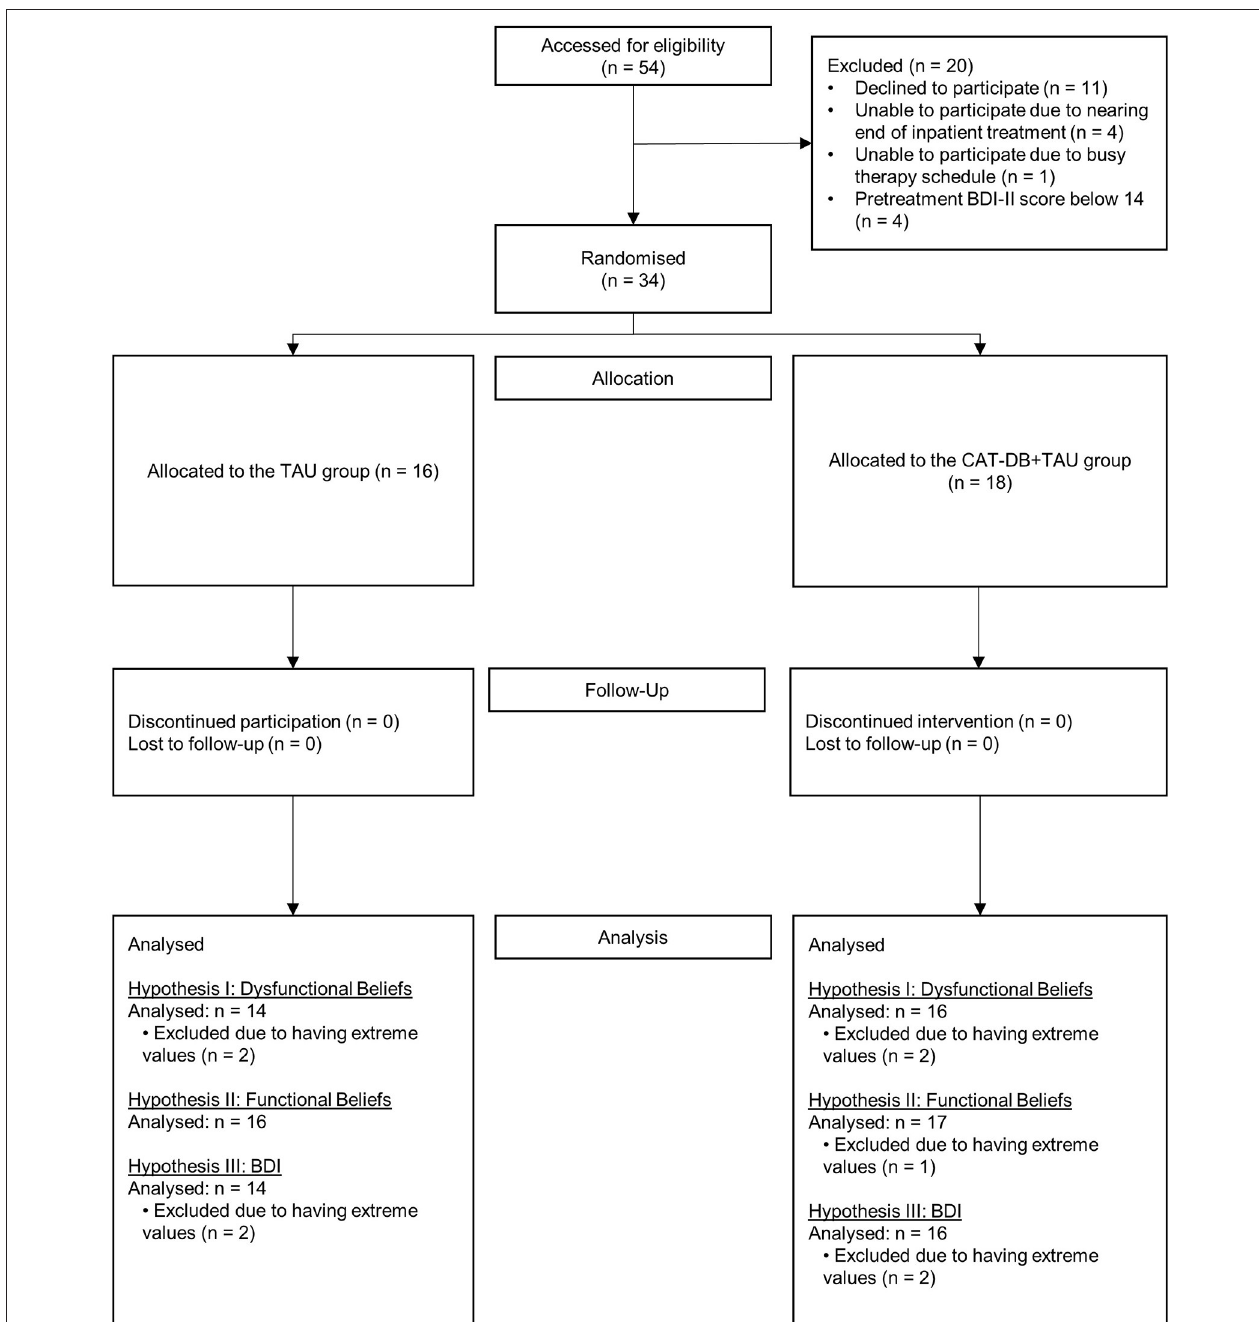
FIGURE 1 | Participant flow